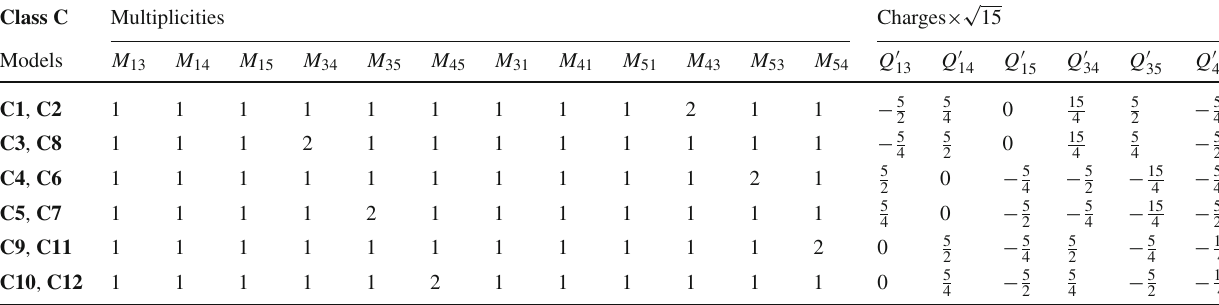
Table 15 Singlets spectrum of Class C